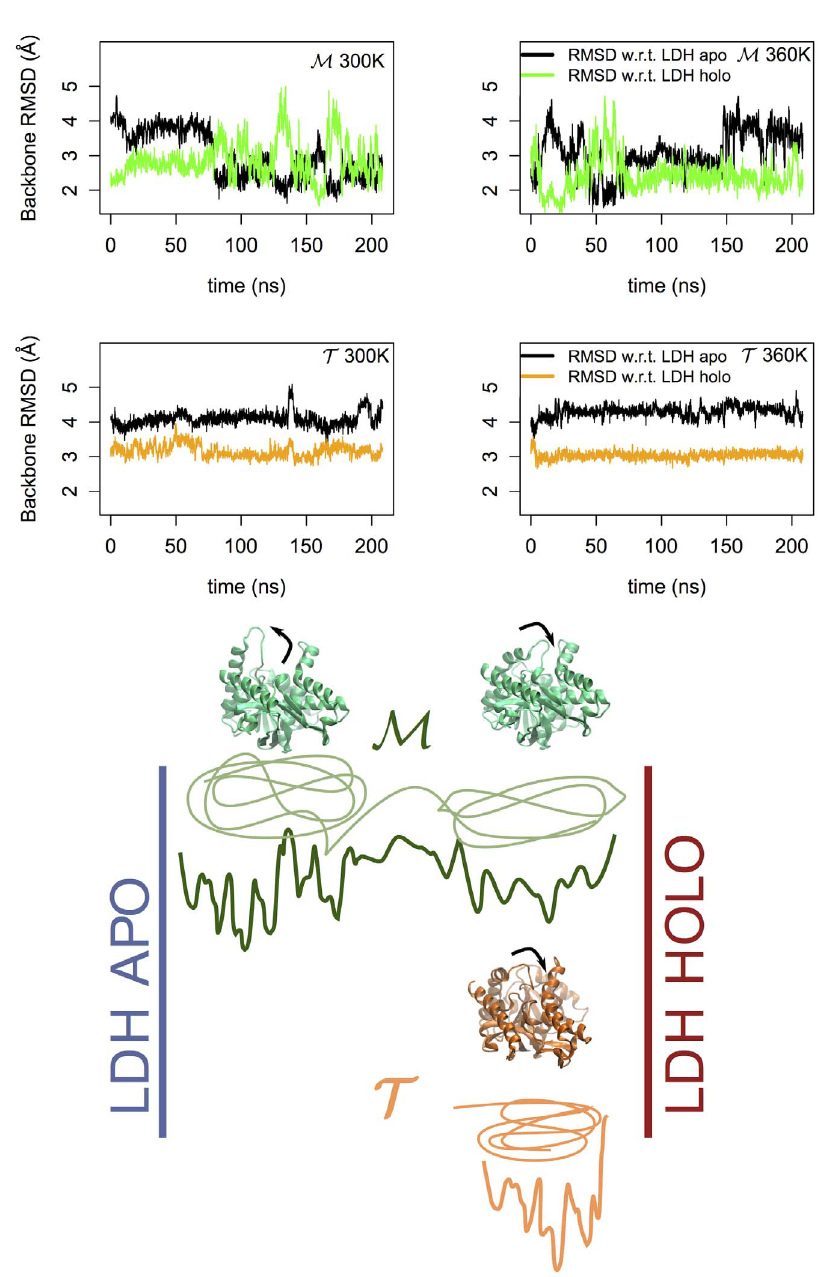
Figure 7. Catalytic pocket dynamics. In the upper part of the figure we report the RMSD computed using the backbone heavy atoms of the residues that form the catalytic pocket of M (upper graphs) and T (bottom graphs) w.r.t. those of the apo and holo forms of lactate dehydrogenase at 300 K (left) and 360 K (right). In the lower part of the figure we present a pictorial representation of the conformational states accessible by the proteins when considered as function of the distance with respect to LDH apo and holo conformers. In green we sketched the two states visited by the M MalDH, one characterized by an open conformation of the binding site loop and the other associated to a closed state. The T MalDH (orange) is instead tightly confined in a closed